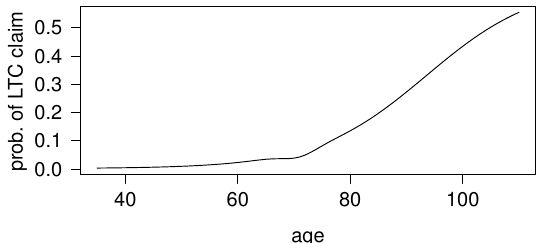
Figure 3. Function w x ( i.e. , probability of entering the LTC state, as a function of the attained age x ): males.